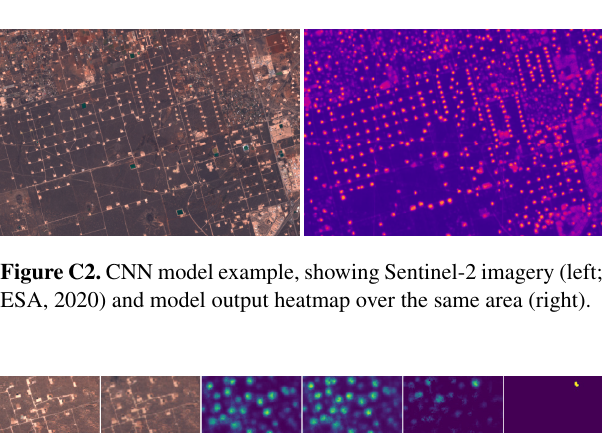
Figure C1. Examples of image–target pairs: (left) Sentinel-2 RGB imagery (ESA, 2020) and (right) ground truth.